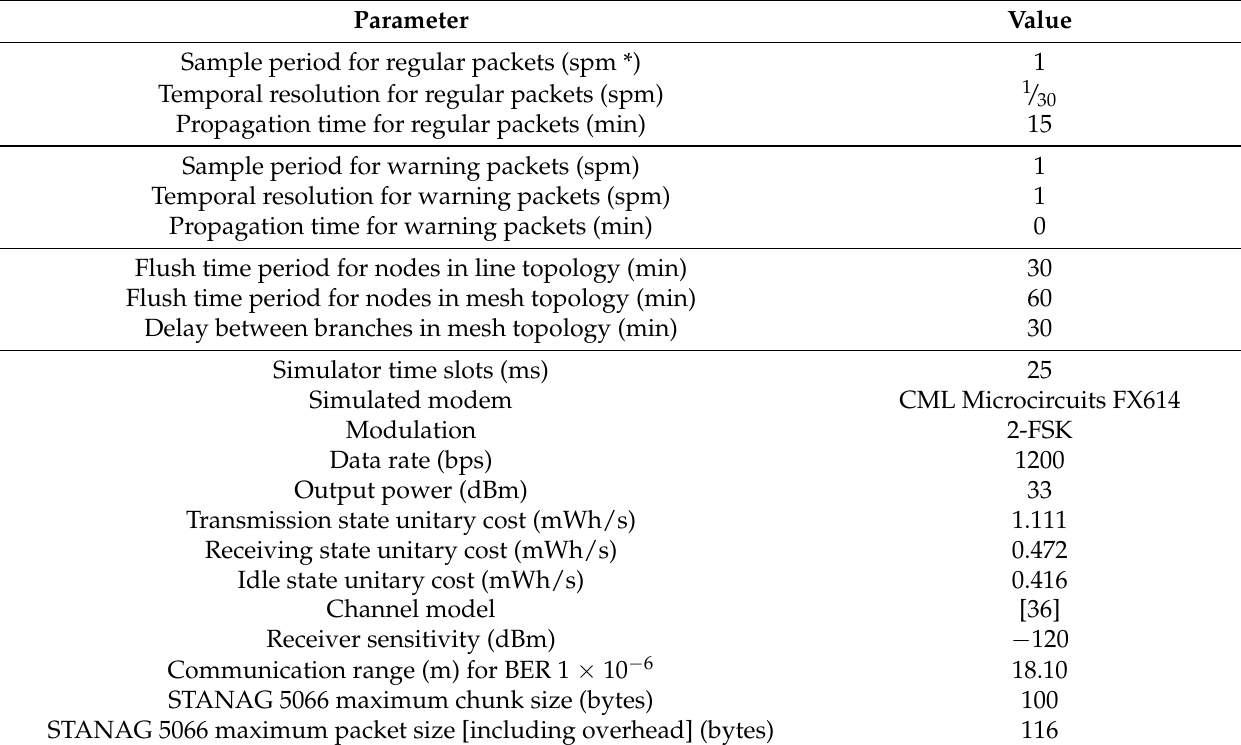
Table 1. Network’s scheduled